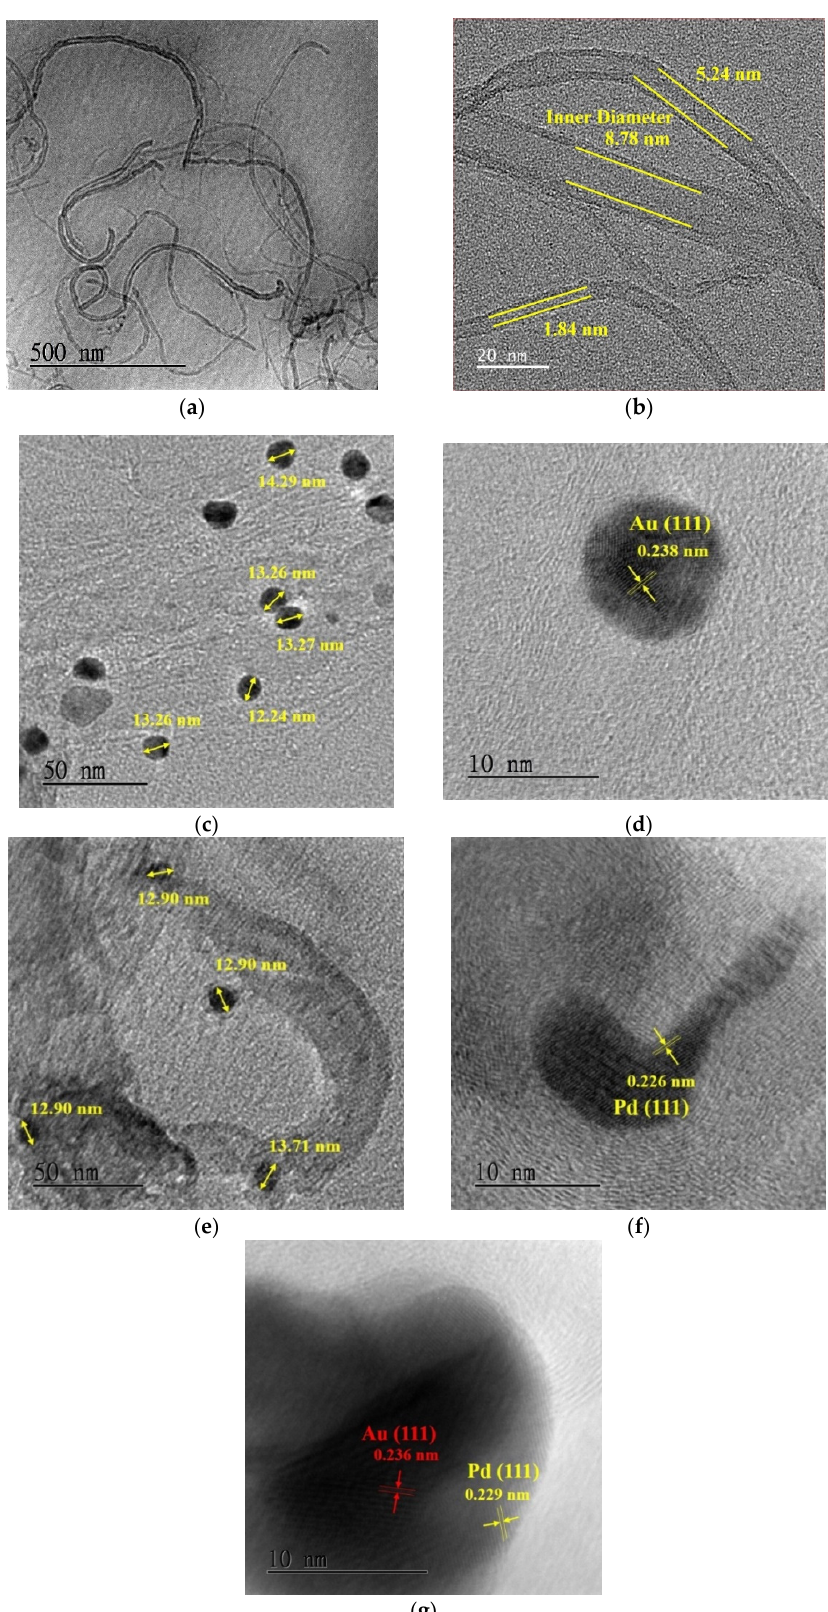
Figure 3. SEM images of ( a ) MWCNT, ( b ) 1% Au/MWCNT, ( c ) 1% Pd/MWCNT, ( d ) 1% Pd-5% Au/MWCNT.